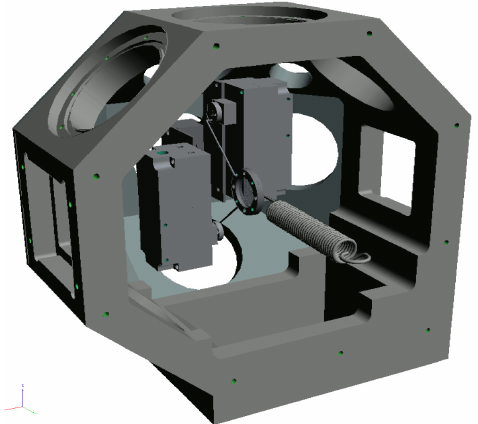
Fig. 2. Two-axis swivelling system to uniformly expose the target to the beam and hence energy deposition. The beam traverses the chamber from left to right. The sides and blanking flanges of the vacuum chambers are deleted from the 3D drawing for viewing purposes.